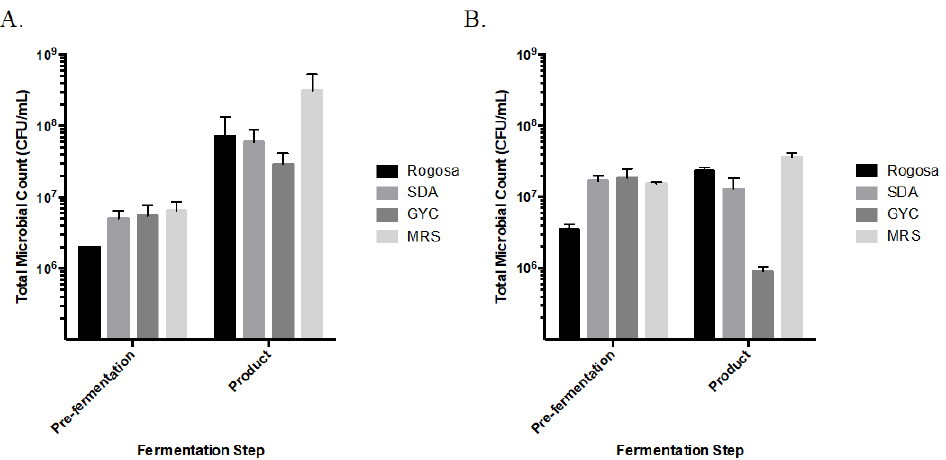
Figure 3. Total microbial colony counts (CFU / mL) of fermented cashew product samples. ( A ) ‘Brie’ and ( B ) ‘blue’ cashew product. Mean and standard deviation are presented. Data are in duplicates.